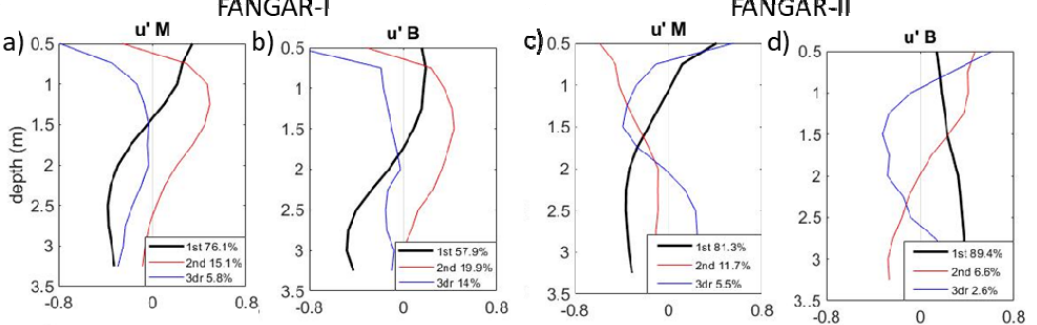
Figure 13. Empirical orthogonal functions (EOF) analysis for low-frequency filtered data during FANGAR-I ( a , b ) and FANGAR-II ( c , d ) along-shore currents. The legend shows the corresponding percentage of the explained variability.